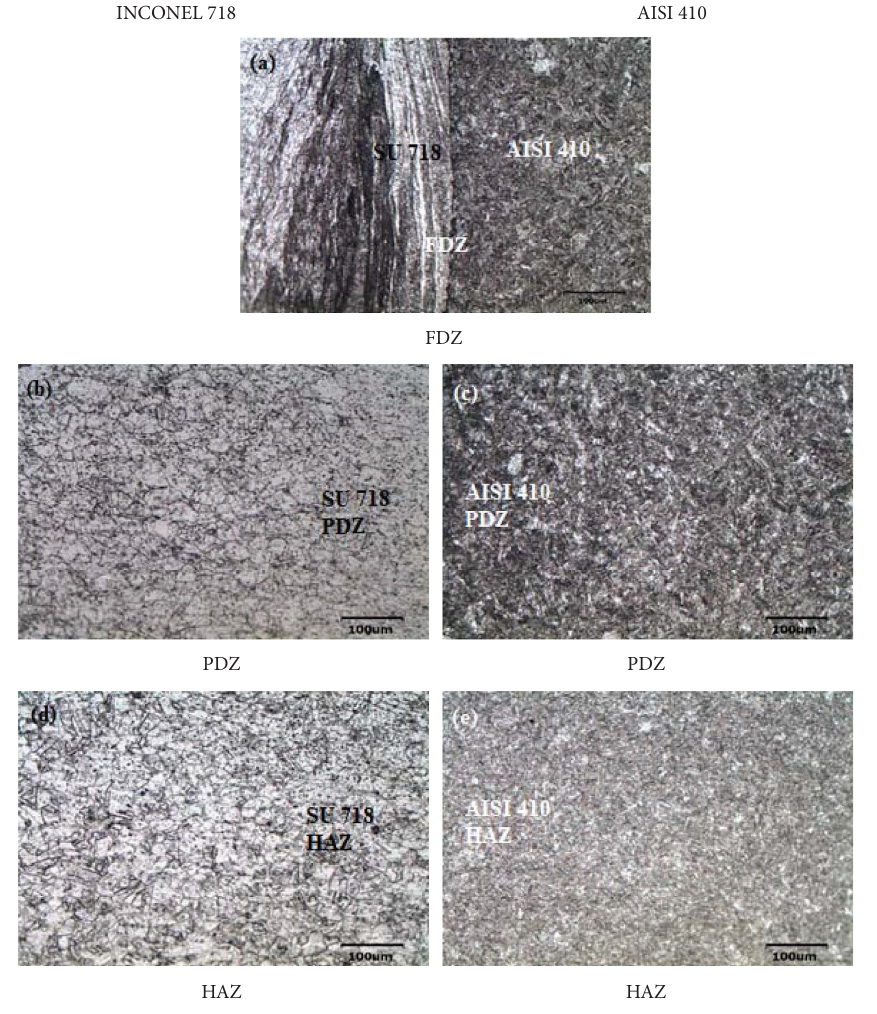
Figure 7: Dissimilar weld joint microstructure at